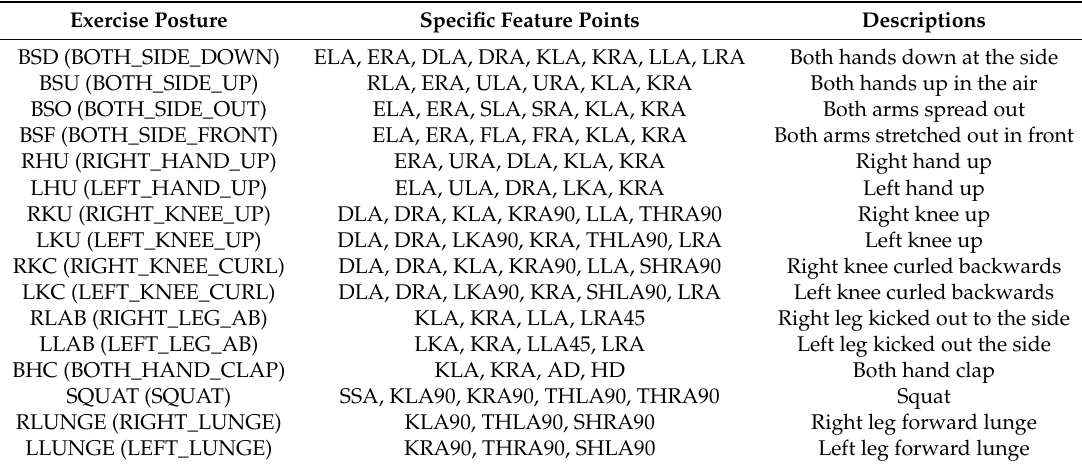
Table 2. Feature Specifications for 16 Exercise